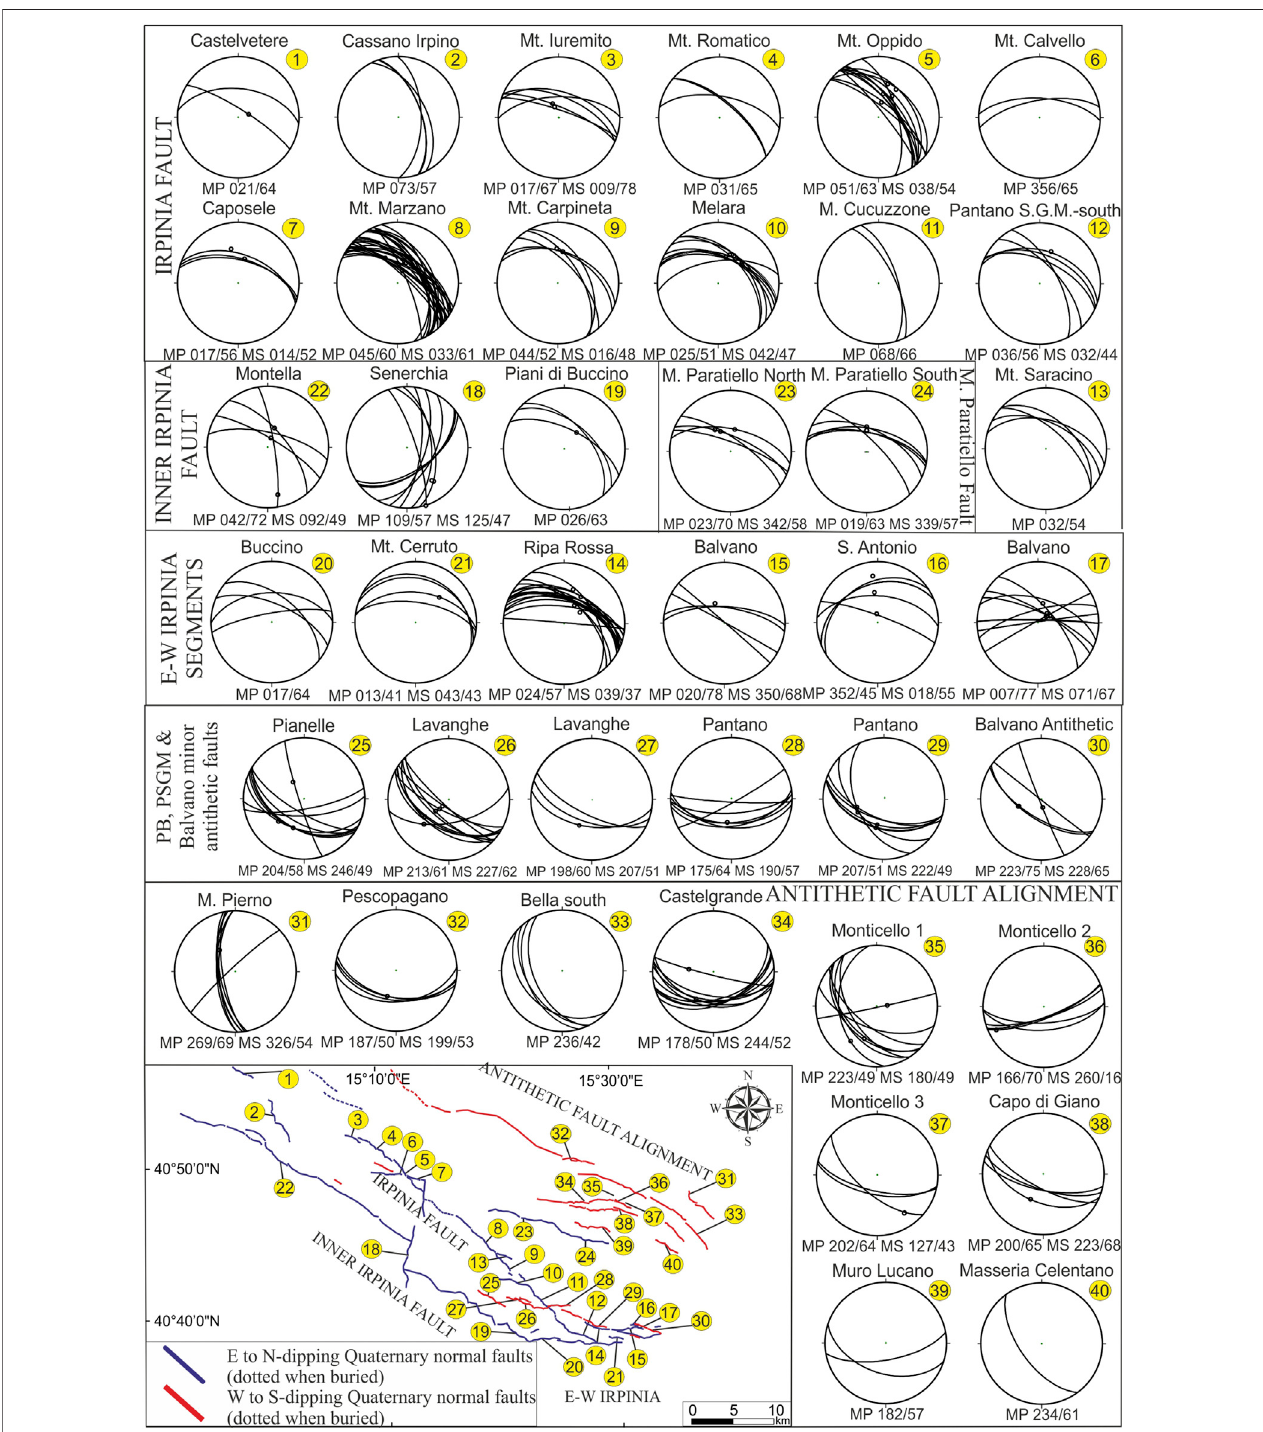
FIGURE 4 | Structural analysis carried out on the Quaternary normal faults outcropping in the Campania – Lucania 1980 earthquake epicentral area. Stereoplots of surveysites(SS)depictingnormalfaults(greatcircles)andstriatednormalfaults(greatcircleswithsmallblackcircles)aregroupedbythefaultorfault-alignmentonwhich the data were acquired. Only normal or normal-oblique senses of slip were observed. The map (lower left) shows, as small yellow circles, the location of the SS that consist either of structurally homogeneous outcrops, or group of close outcrops. Sites are numbered from north to south for each of the reconstructed structures.